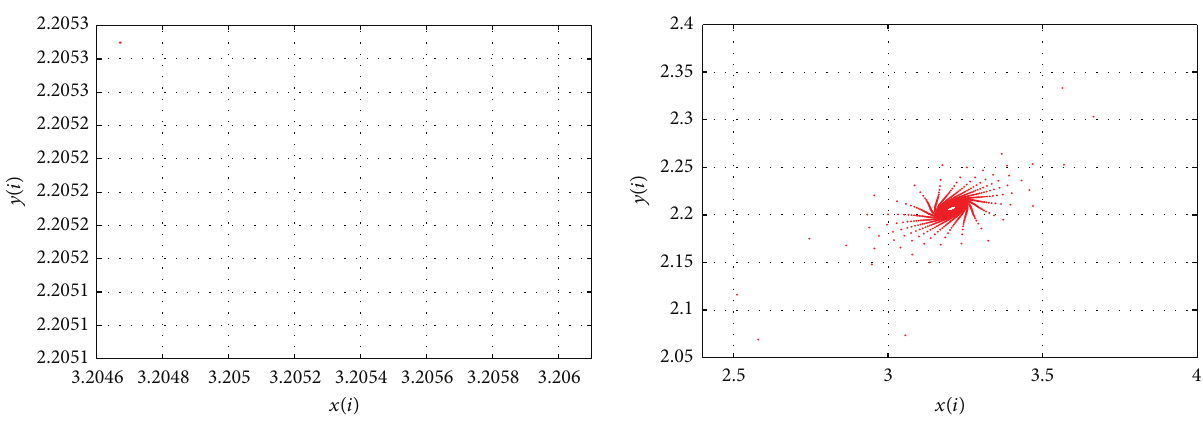
Figure 10: The portraits for several values of 𝐴 1 = 0.03 , 𝛿 = 4.875 , and 𝛿 = 4.8795